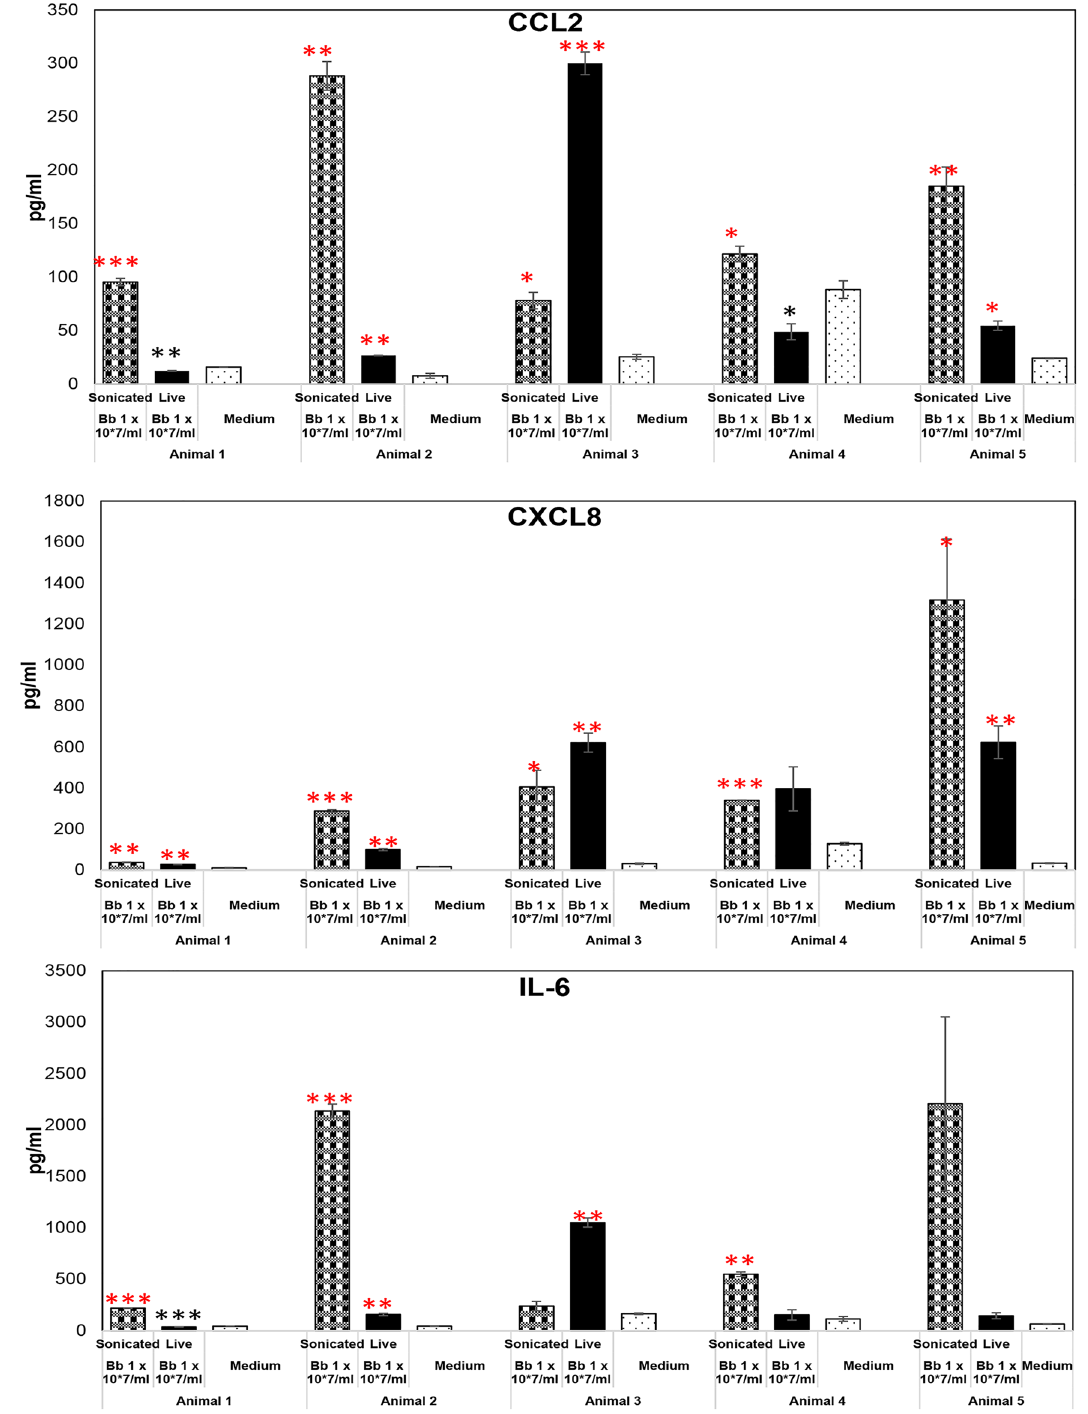
Figure. 1. Non-viable B. burgdorferi mediates inflammatory mediator release from rhesus FC. The effect of live or sonicated B. burgdorferi on inflammatory mediator release from rhesus frontal cortex tissues is shown in this figure. Ex vivo cultured tissues were exposed to indicated treatments for 4 h. Supernatants were analyzed for CCL2, CXCL8 and IL-6. Results from tissues obtained from 5 different animals is shown. ***p < 0.001; **p < 0.01; *p < 0.05. Significantly increased levels over medium control is denoted by the red asterisks, while black asterisks indicate they were below medium levels. Bars represent standard deviation. Live bacteria were used as a positive control, while medium exposed tissues were used as a negative control throughout the